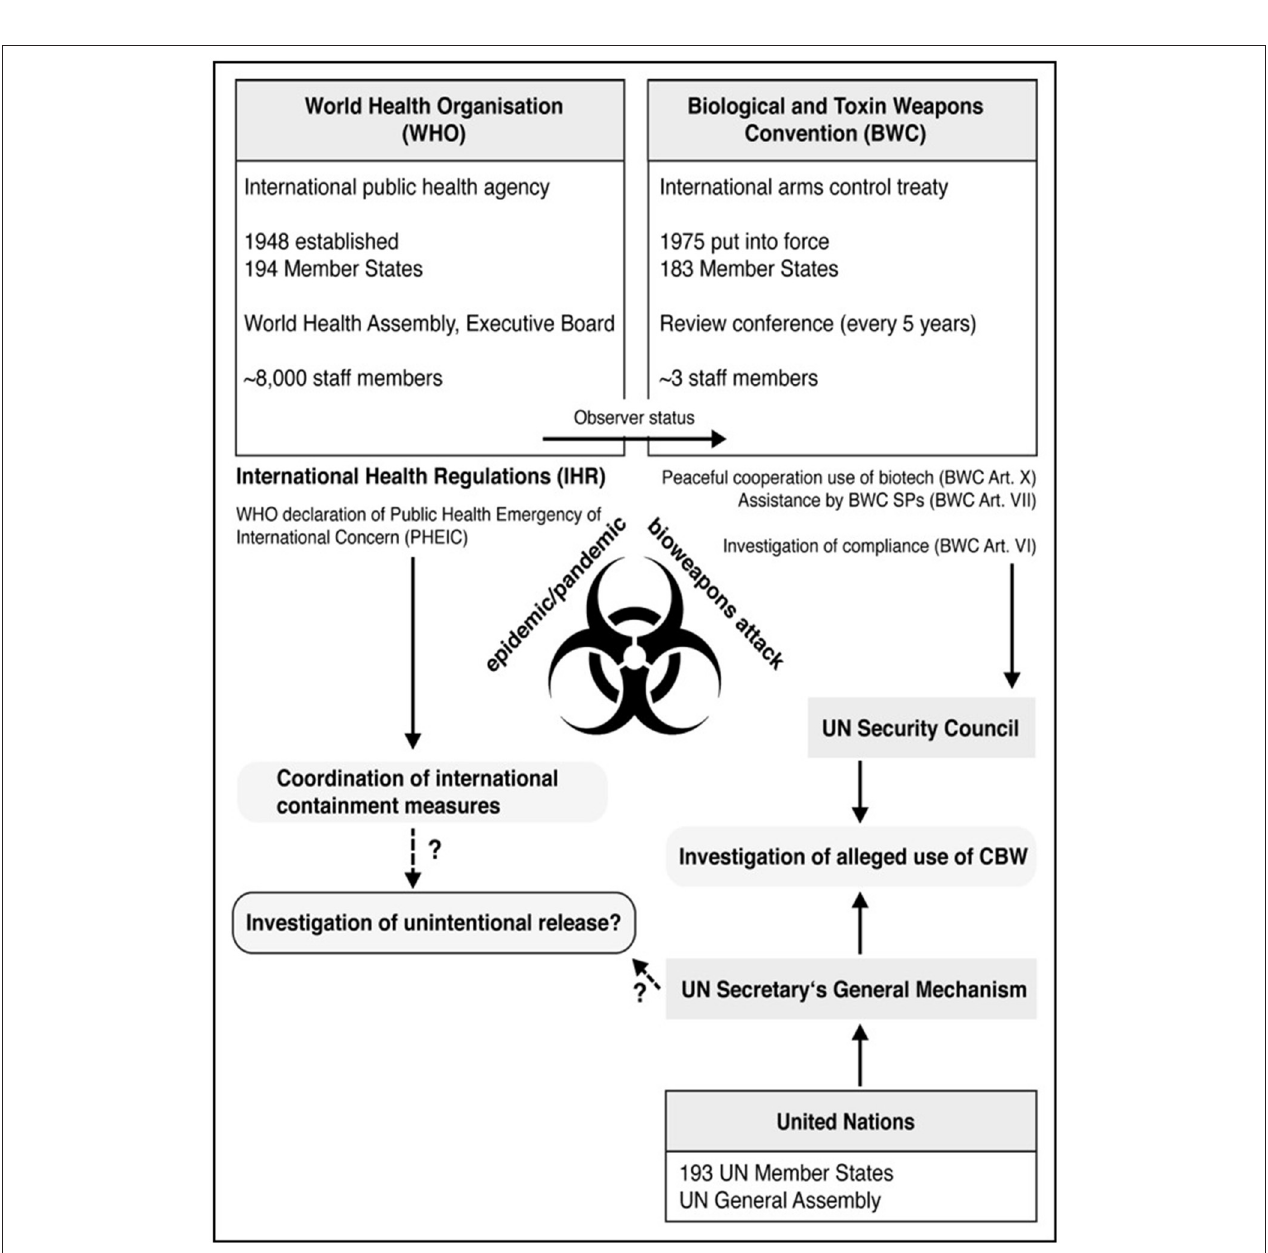
FIGURE 1 | Possible interplay between WHO and BWC investigative mechanisms. Shown are key features of both, the WHO and the BWC regime including status of membership and decision-making bodies. Although acting in different areas (WHO, human health; BWC, biological arms control), there might be an interplay between internationally agreed investigative mechanisms usable for the analysis of the COVID-19